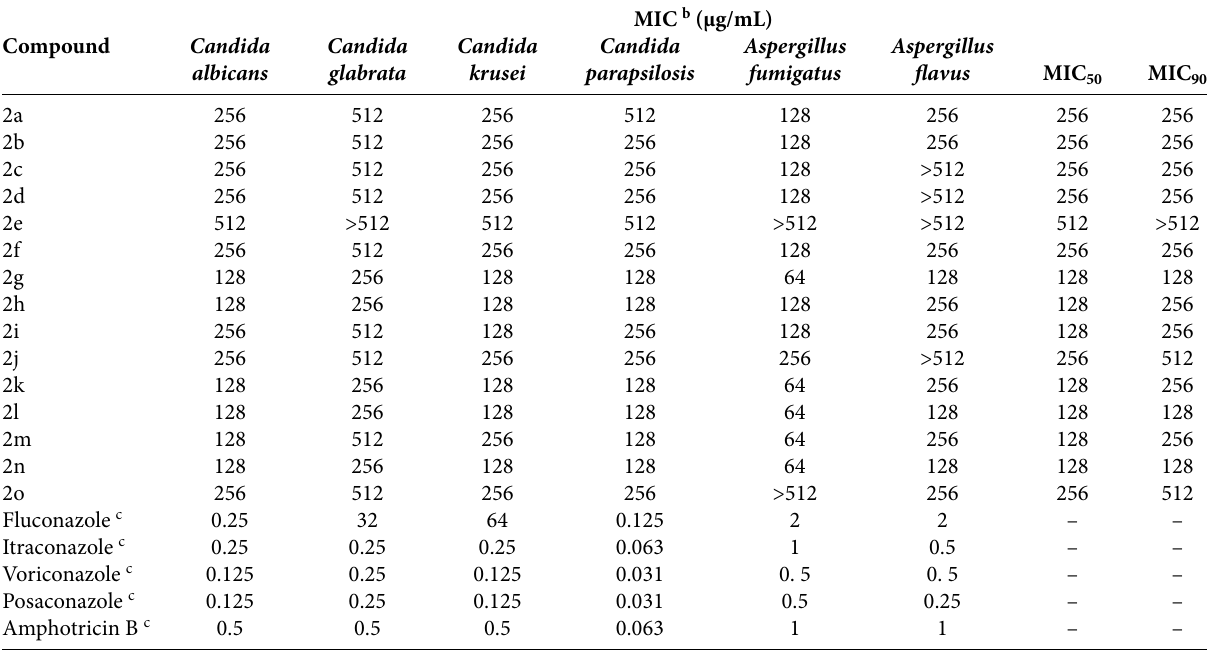
Table 6. In vitro susceptibility testing of 6 standard isolates of yeasts and filamentous fungi to four antifungal agents and 15 novel compounds, and MIC 50 and MIC 90 values expressed in µg/ml for 5-substituted-1 H -tetrazole derivatives